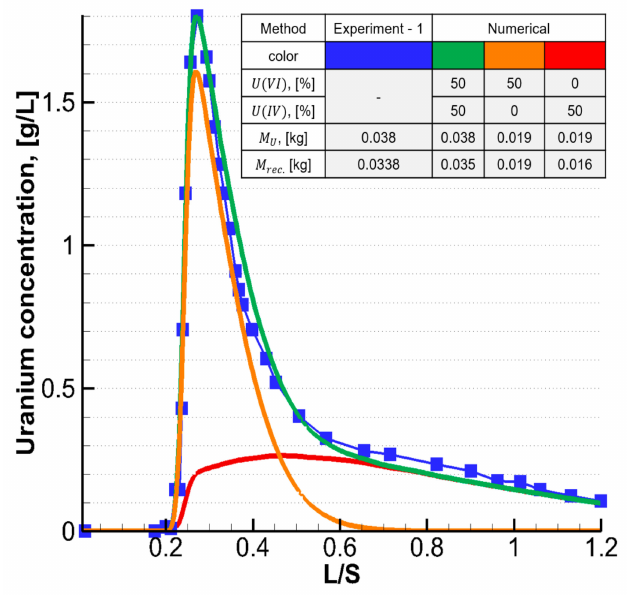
Figure 10. Uranium concentration at the outlet tube for various cases.